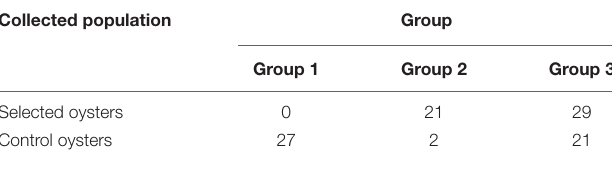
TABLE 2 | Summary of groups for genetic structure analysis by